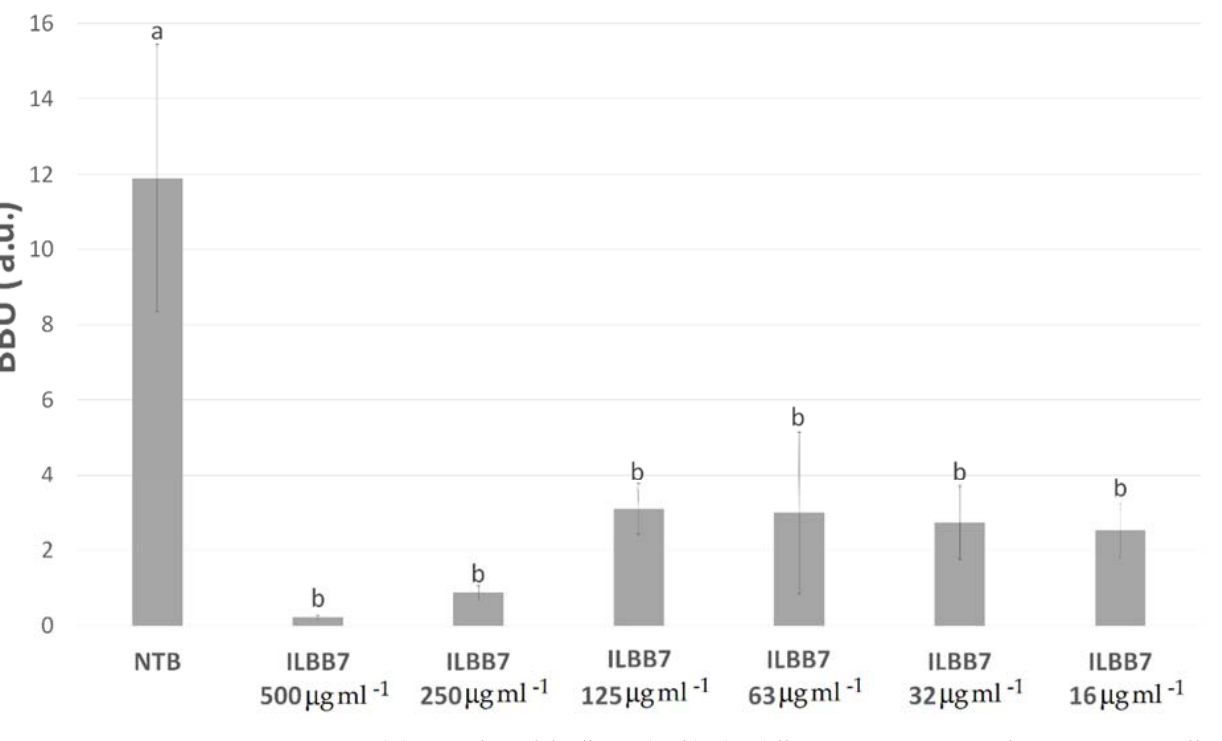
Figure 4. Inhibition of Candida albicans biofilm by different concentrations of ILBB7 extract. Different letters (a, b) represent significant differences ( p <